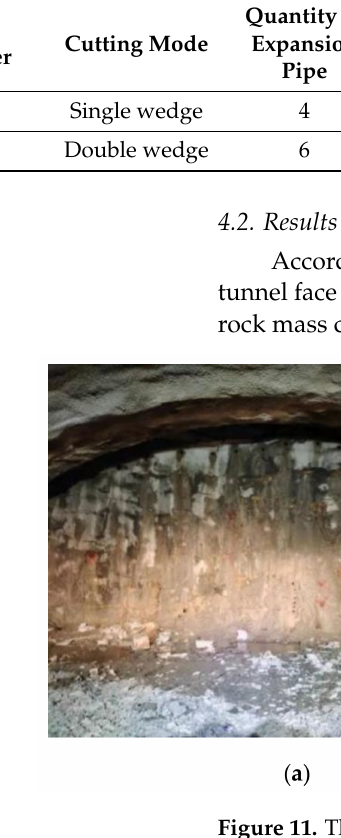
Figure 11. The comparison before and after rock mass cracking in the test 3. ( a ) Tunnel face before rock mass cracking; ( b ) Tunnel face atter rock mass